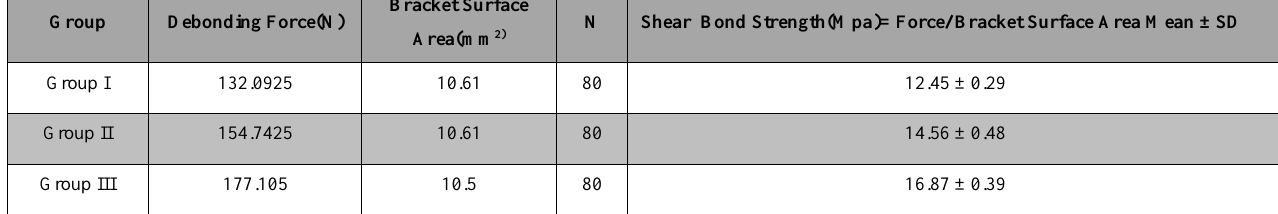
Table 2. Shear bond strength (Mpa) of three groups.